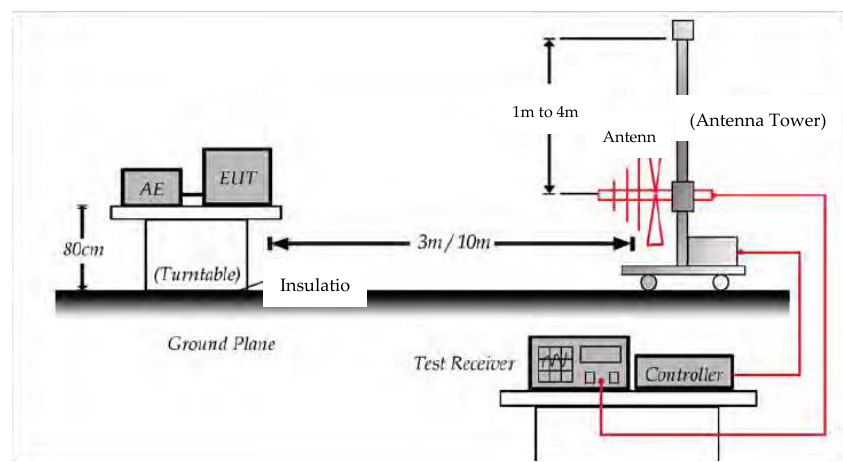
Figure 11. EN55022 electromagnetic interference (EMI) official site configuration map.